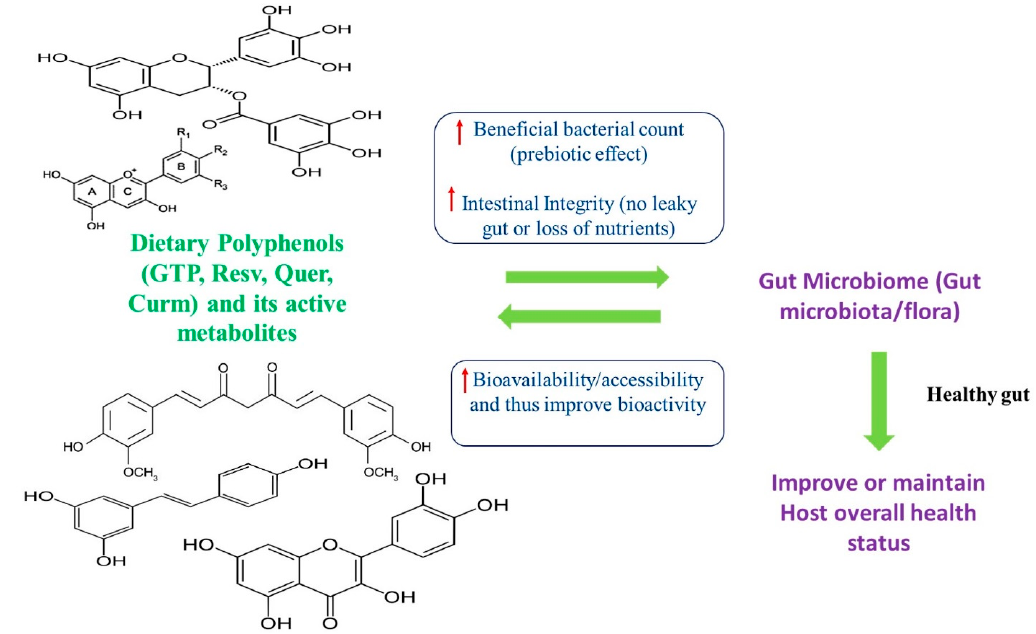
Figure 2. An interplay between dietary polyphenols and the gut microbiome. The upper arrow indicates an increase. GTP—Green tea polyphenol, Curm—Curcumin, Resv—Resveratrol, Quer—Quercetin.